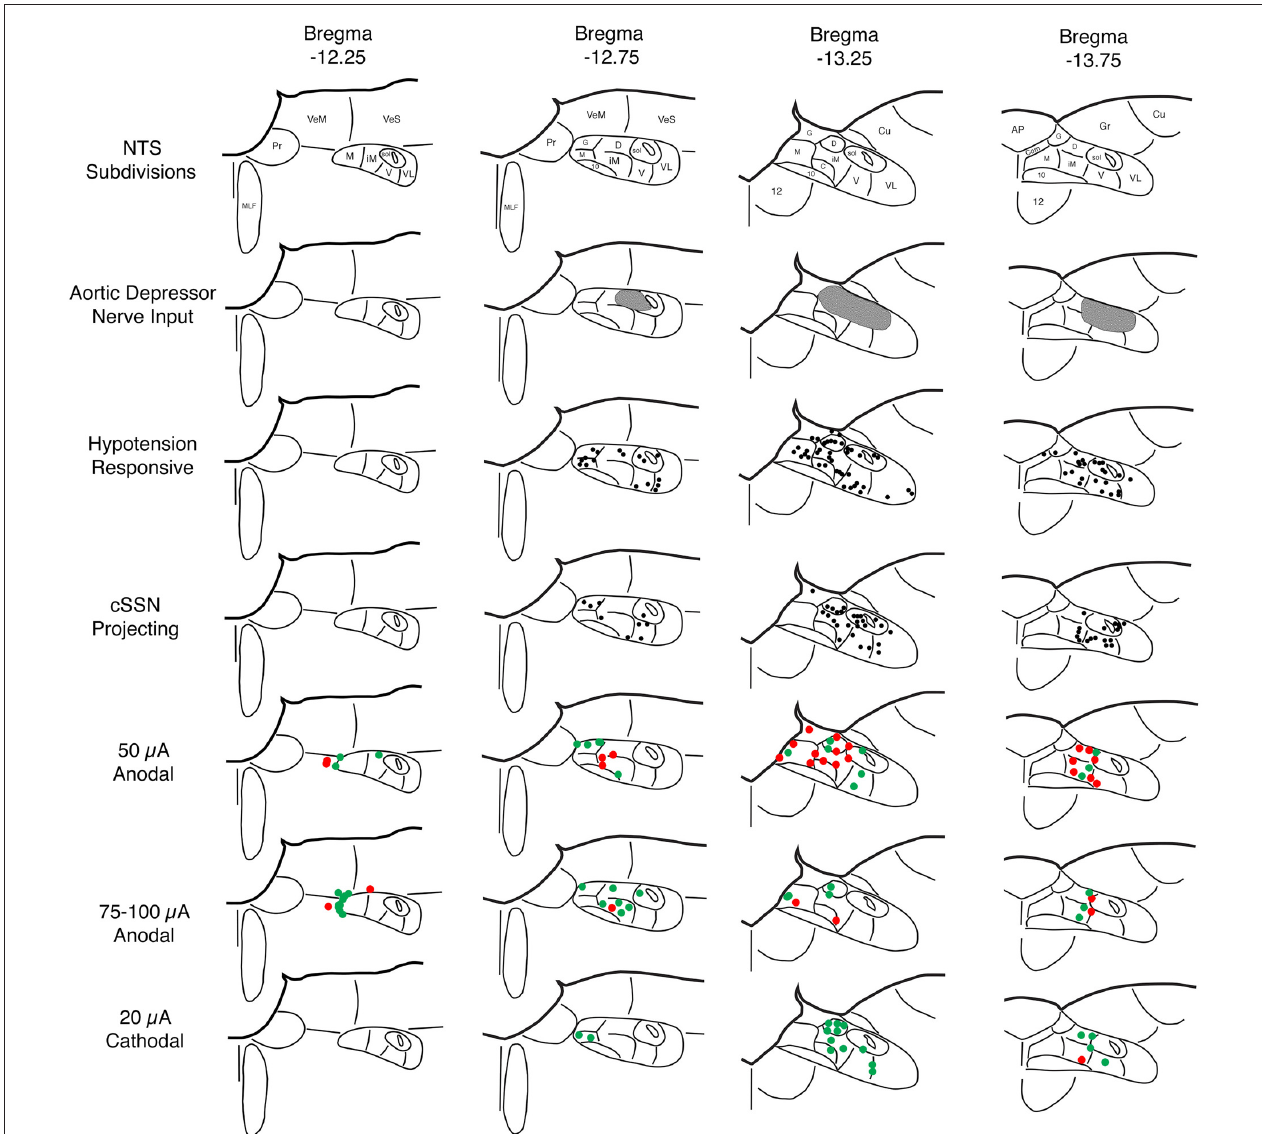
FIGURE 2 | Schematic illustration showing: (1) the NTS subdivisions (row 1); (2) the distribution of the aortic depressor nerve (ADN) input to superior salivatory nucleus (SSN) according to published studies by others (row 2; Ciriello, 1983; Housley et al., 1987; Altschuler et al., 1989); (3) the distribution of c-fos immunolabeling in NTS induced by hypotension as indicated in the present study and as consistent with prior reports by others (row 3; Rogers et al., 1993; Mayne et al., 1998); (4) the distribution of neurons in NTS that project to choroidal SSN (cSSN) as revealed from our prior studies involving intrachoroidal injection of pseudorabies virus (row 4; Li et al., 2015); (5) the distribution of sites within NTS yielding a significant choroidal blood flow (ChBF) increase (green) or no significant ChBF increase (red) in response to 50 µ A anodal current pulses (row 5); (6) the distribution of sites within NTS yielding a significant ChBF increase (green) or no significant ChBF increase (red) in response to 70–100 µ A anodal current pulses (row 6); and (7) the distribution of sites within NTS yielding a significant ChBF increase (green) or no significant ChBF increase (red) in response to 20 µ A cathodal current pulses (row 7). Note that hypotension responsive and cSSN neurons overlap one another, and both overlap but extend beyond the zone of ADN input. Thus, hypotension responsive and cSSN neurons either extend their dendrites into the ADN-receptive zone and/or receive input from AND-receptive neurons to account for the baroresponsiveness. The stimulation data indicate that ChBF increases can be driven by anodal stimulation in rostromedial NTS along the course of the axons traveling from NTS to cSSN and by cathodal stimulation within the region enriched in hypotension responsive and cSSN projecting